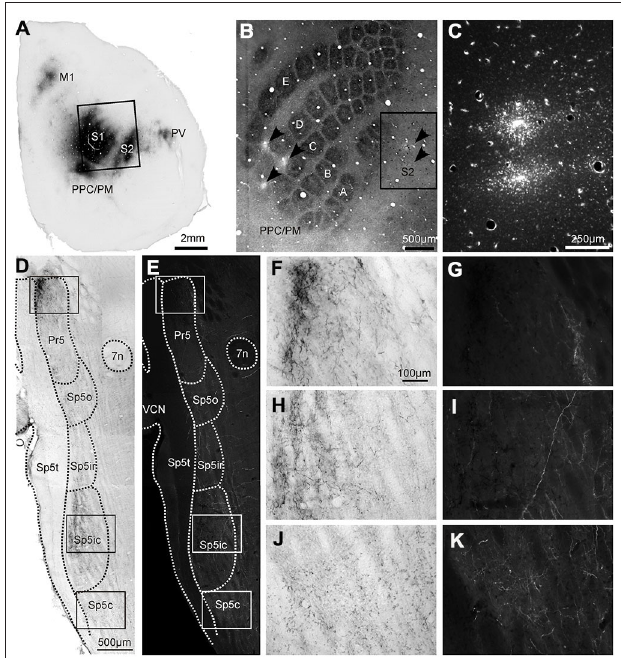
FIGURE 1 | Labeling patterns in the trigeminal sensory nuclei following dual anterograde tracer deposits in the whisker representations of primary (S1) and secondary somatosensory (S2) cortices. (A) Photomicrograph of tangential cortical section processed for Biotinylated Dextran Amine (BDA) (B) . Locations of the tracer deposits in the (C,D) rows of S1 (BDA) and (B–D) rows of S2 (FR) shown on a tangential section of the cortex through layer IV, processed for cytochrome oxidase (CO). (C) Adjacent section processed for the fluorescent tracer Fluoro Ruby (FR), which was injected at two locations in the S2 whisker representation corresponding to the inset in (B) . (D) Horizontal section through the contralateral trigeminal sensory nuclei processed for BDA shows different nuclei and anatomical landmarks (dotted lines), identified from an adjoining CO section. (E) The same section viewed using a TRITC filter for FR visualization showing labeled terminals across trigeminal sensory nuclei. (F,H,J) Photomicrographs of the areas in the insets of 1D show the morphology of BDA-labeled terminals in Pr5, Sp5ic and Sp5c, respectively. (G,I,K) The areas under the same insets (E) but viewed using a TRITC filter to show the morphology of FR labeled terminals. The BDA reaction product can be seen on the same photomicrographs. Abbreviations: M1, primary motor cortex; PPC/PM, posterior parietal cortex/posterio-medial cortex; Pr5, principal trigeminal nucleus; Sp5o, spinal trigeminal nucleus pars oralis; Sp5ir, spinal trigeminal nucleus pars interpolaris rostral; Sp5ic, spinal trigeminal nucleus pars interpolaris caudal; Sp5c, spinal trigeminal nucleus pars caudalis; Sp5t, spinal trigeminal tract; 7n, nucleus of the 7th cranial nerve; VCN, ventral cochlear